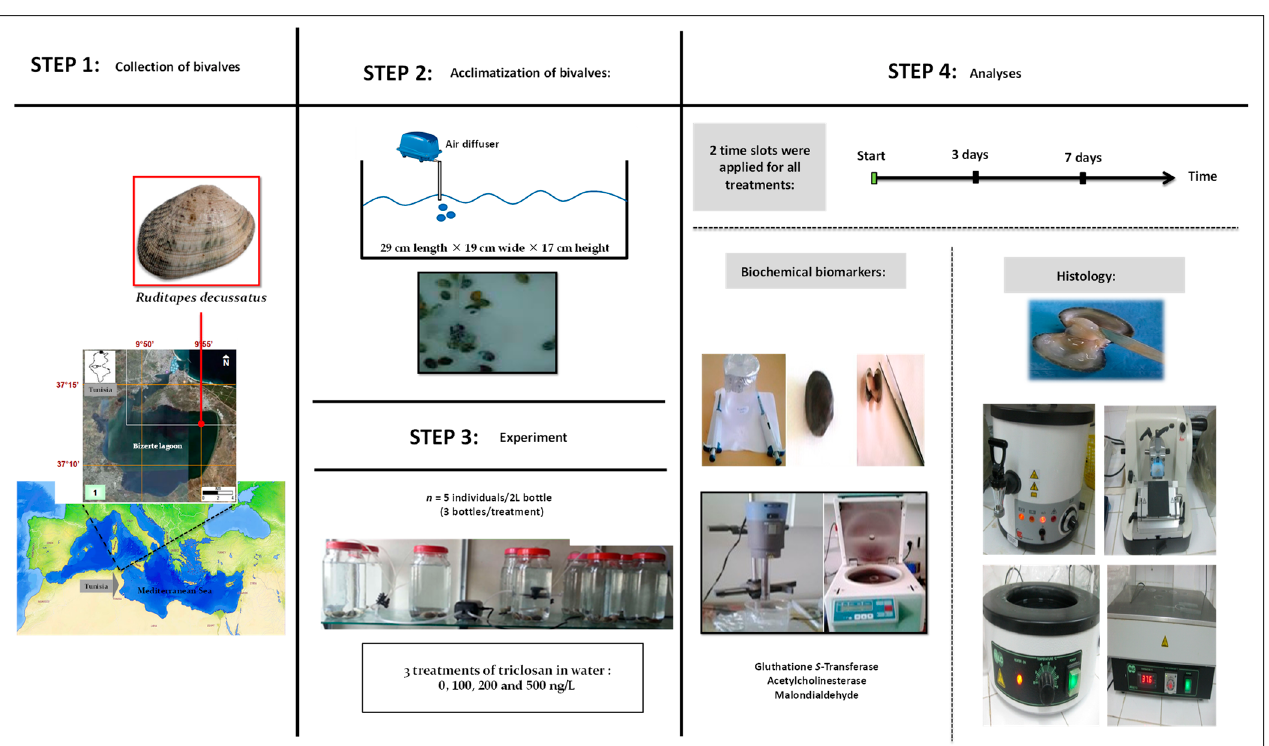
Figure 1. Graphic summary of steps and working methodology.